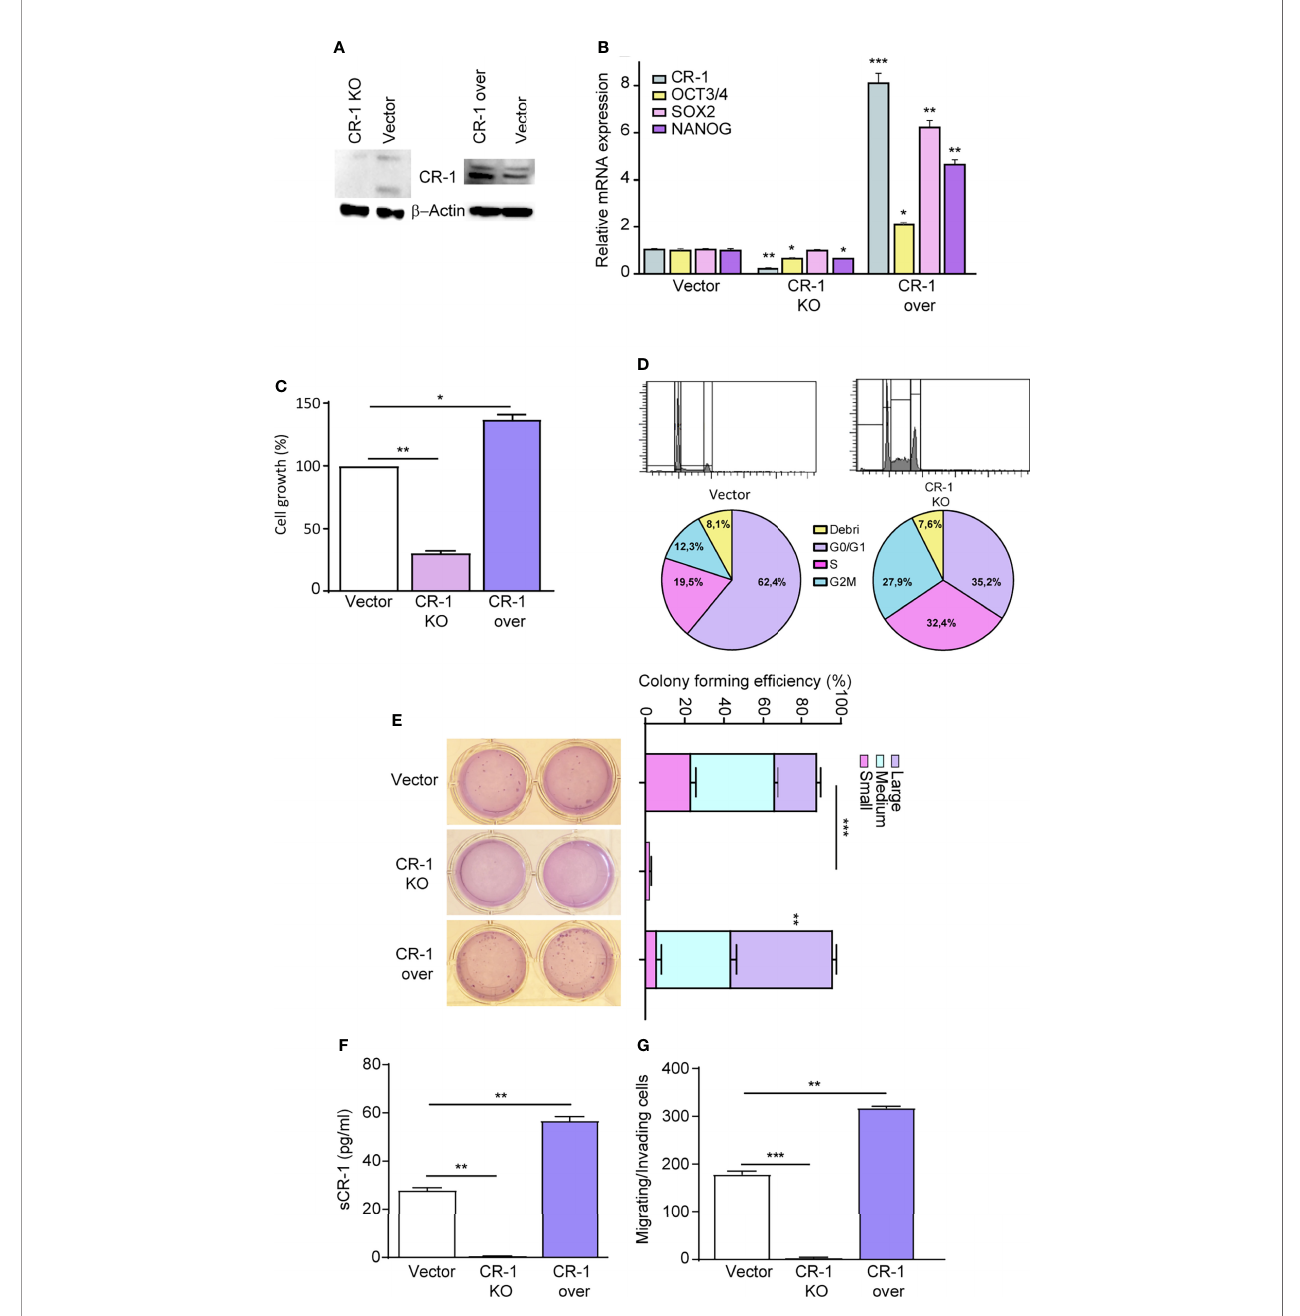
FIGURE 2 | CRIPTO (CR-1) expression regulates cells proliferation and stem cell gene expression in NSCLC spheroids. (A) Immunoblot analysis of CRIPTO and b Actin in SCC1 spheroids transduced with the empty vector (Vector), with CRIPTO shRNA vector (CRIPTO KO) or with exogenous CRIPTO (CRIPTO-over). (B) CRIPTO and stem cell genes (OCT3/4, SOX2, NANOG) mRNA expression in SCC1 transduced with vector, CRIPTO KO or CRIPTO-over sequences. (C) ATP assay performed on SCC1 transduced with the vector, CRIPTO KO or CRIPTO-over sequences, performed 4 days after transduction (D) . Cell cycle analysis of SCC1 transduced as above, performed 3 days after transduction. (E) Soft agar pictures (left; two technical replicates for each sample) and graph (right) of colony forming assay performed on control (Vector), CRIPTO KO and CRIPTO overexpressing SCC1 spheroids. The results are evaluated as colony formation in semisolid culture and expressed as normalized colony size/percentage over plated cells. (F) ELISA assay performed on SCC1 cells transduced with empty vector, CRIPTO KO sequences and CRIPTO overexpression vector. (G) Invasion/migration assay performed on vector-transduced, CRIPTO KO and CRIPTO overexpressing SCC1 cells. *P < 0.05; **P < 0.01, ***P < 0.001 by unpaired student ’ s t test (transduced vs